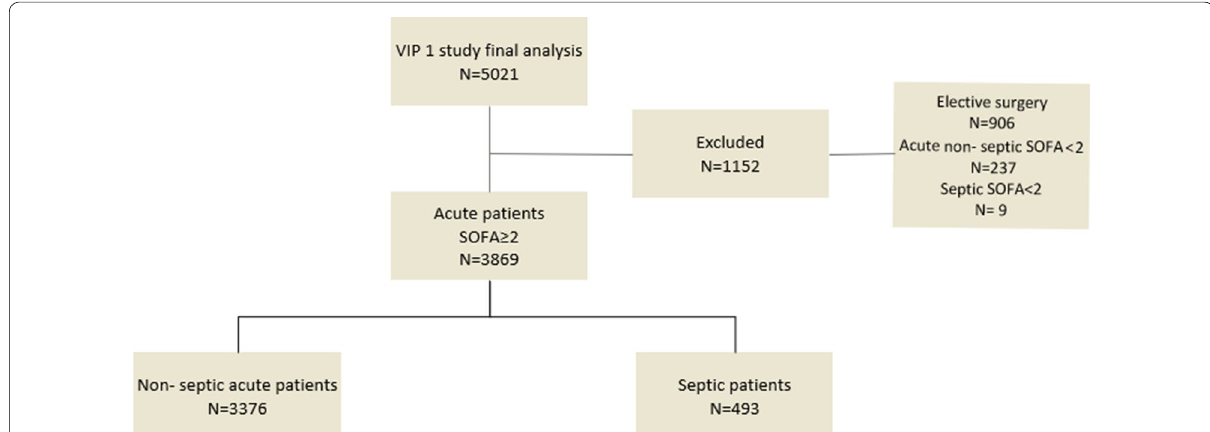
Fig. 1 Study flowchart. VIP1 study [1]. Septic patients: patients admitted to ICU for sepsis; non-septic patients: patients admitted to ICU for another